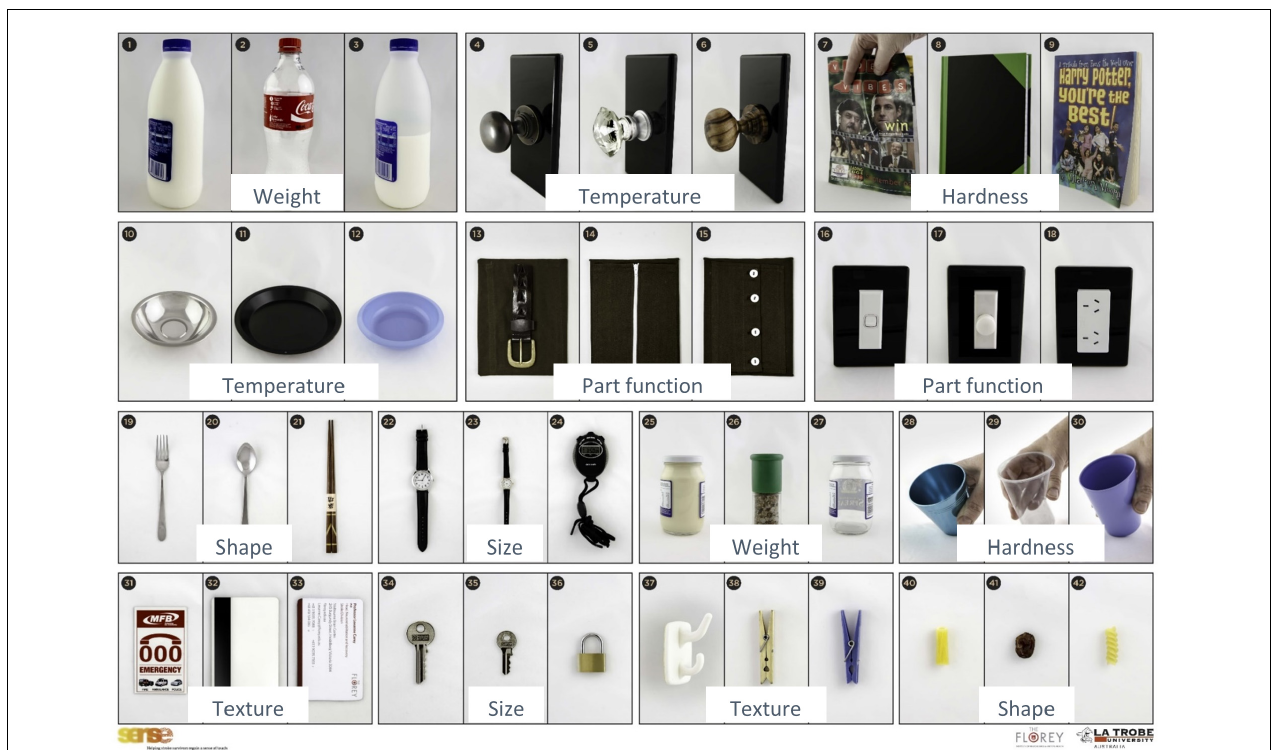
FIGURE 1 | Functional Tactile Object Recognition Test response poster displaying object sets. Sensory attribute tested within object sets, e.g., weight, is labeled for each set in the figure. Figure adapted from Turville et al. (2018). Reproduced with permission. The final publication is available at IOS Press through